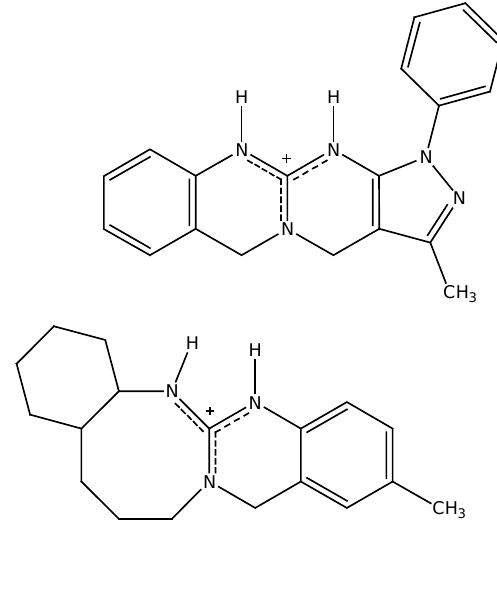
Figure 4. Guanidinium-based